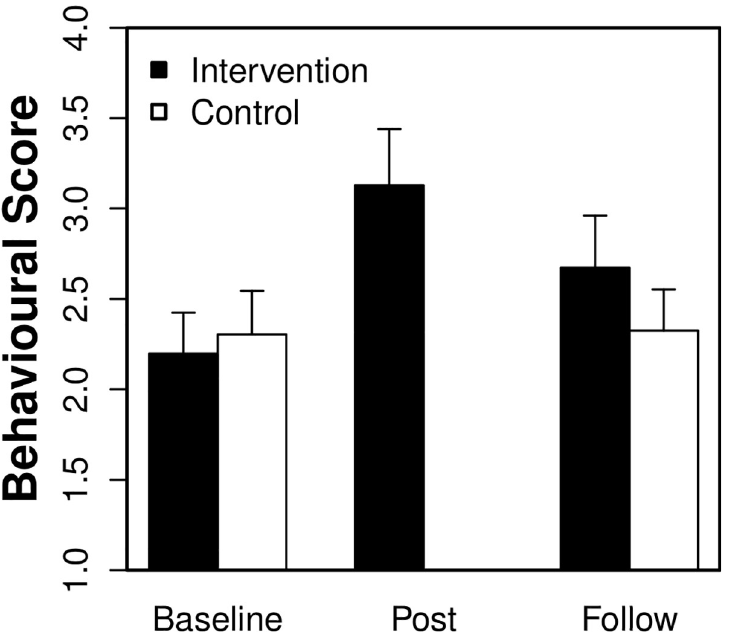
Fig 1. Study 1: Mean (95% CI ) behavioural total scores in the intervention and control groups. The maximum score of 6 reflects engagement in all of the handwashing behaviours observed (i.e., soap, rub, wrists, fingers, nails and